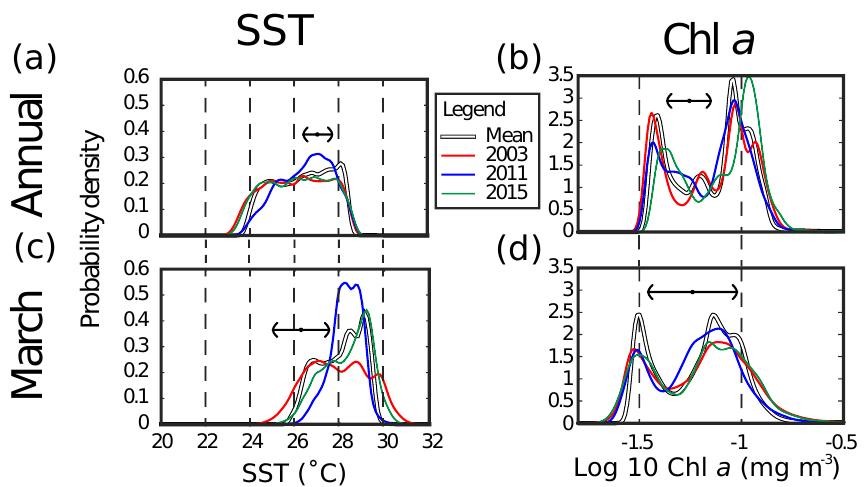
Figure 5. Probability density estimates for MODIS Aqua data in the OUTPACE region, using mean (a) annual SST, (b) annual chl a , (c) March SST, and (d) March chl a . Probability densities for the ensemble of all years is shown in white, while densities for 2003, 2011, and 2015 are in red, blue, and green, respectively. Also plotted are 95% confidence intervals (2 standard deviations) for each subset, estimated using the median variance of pixel interannual variability. Note the logarithmic scale for chl a